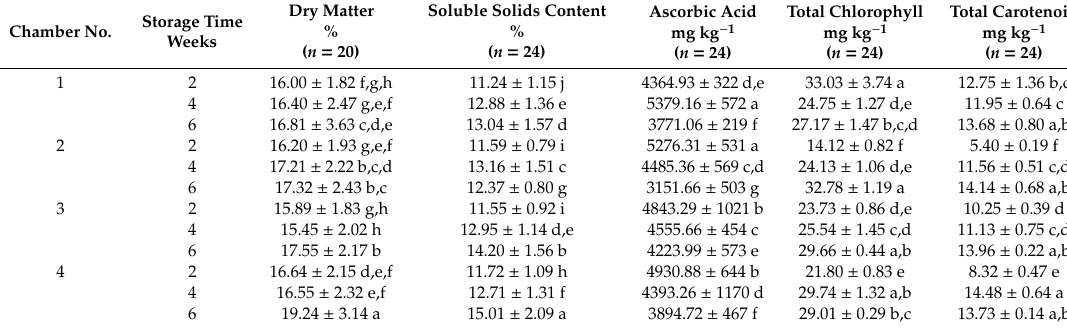
Table 3. Dependence of the chemical composition of Actinidia kolomikta fruit on controlled atmosphere parameters and storage